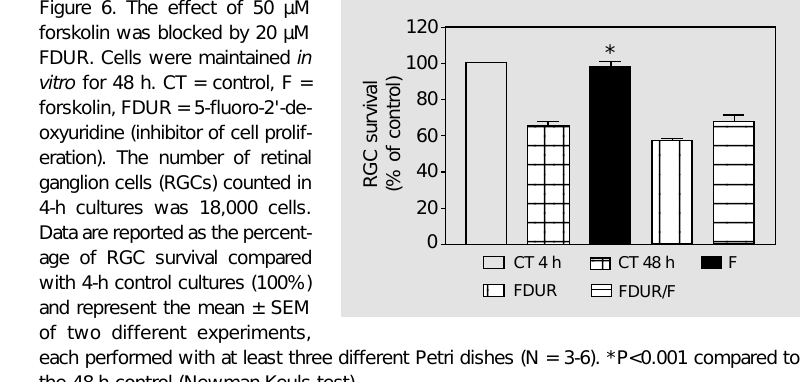
Figure 7. The effect of 50 µM forskolin was inhibited by the blockade of M1 muscarinic re- ceptors. Cells were maintained in vitro for 48 h. CT = control, F = forskolin, A = 10 µM atropine (a muscarinic antagonist), T = 1 µM telezenpine (an M1 antagonist), DAMP = 200 µM DAMP (an M3 antagonist). The number of reti- nal ganglion cells (RGCs) counted in 4-h cultures was 27,000 cells. Data are reported as the percentage of RGC sur- vival compared with 4-h control cultures (100%) and represent the mean ± SEM of three different experiments, each performed with at least three different Petri dishes (N = 3-6). *P<0.001 compared to the 48-h control (Newman-Keuls test).